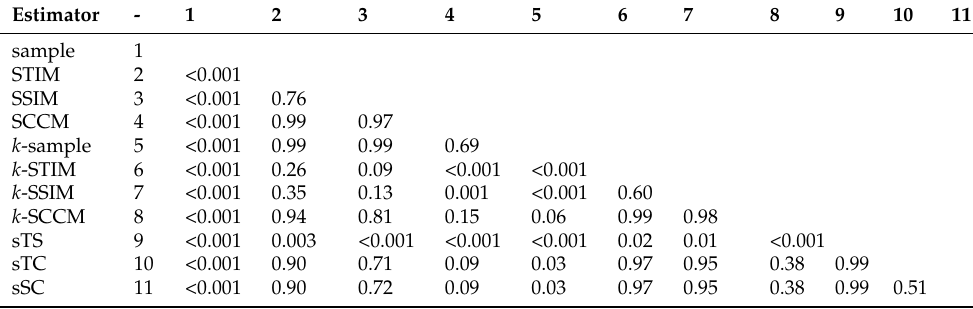
Table A1. p -Value of the annual volatility for each pair of covariance estimators in Table